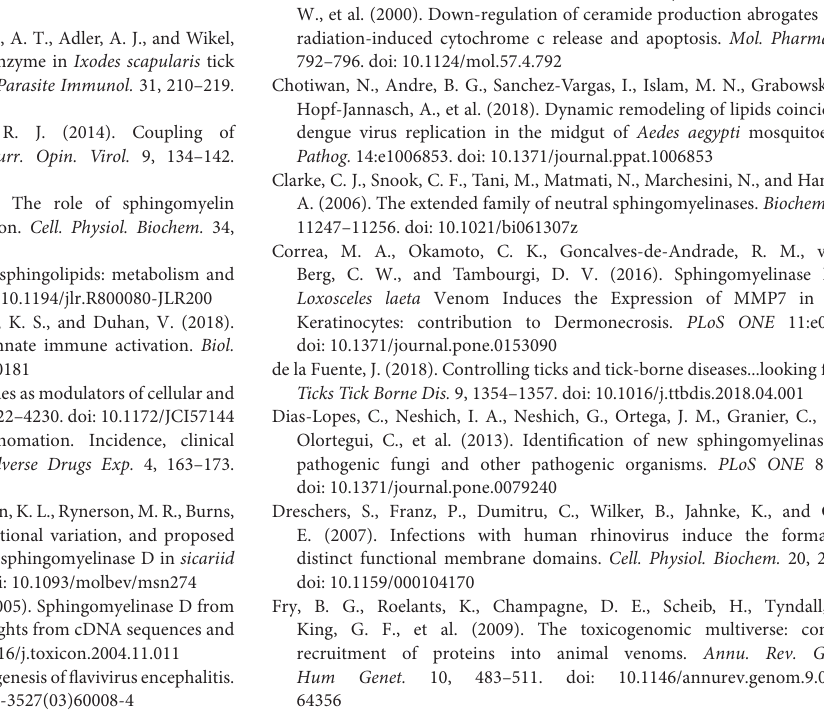
Supplementary Figure 3 | Is SMase expression is unaffected in presence of other pathogens. QRT-PCR analysis showing levels of Is SMase transcripts in unfed I. scapularis nymphs infected with either extracellular bacterium B. burgdorferi or intracellular bacterium A. phagocytophilum . Open circles indicate uninfected (UI) and closed circles denote infected (I) groups. Is SMase mRNA levels were normalized to tick beta-actin levels. No significant differences were noted between UI and I